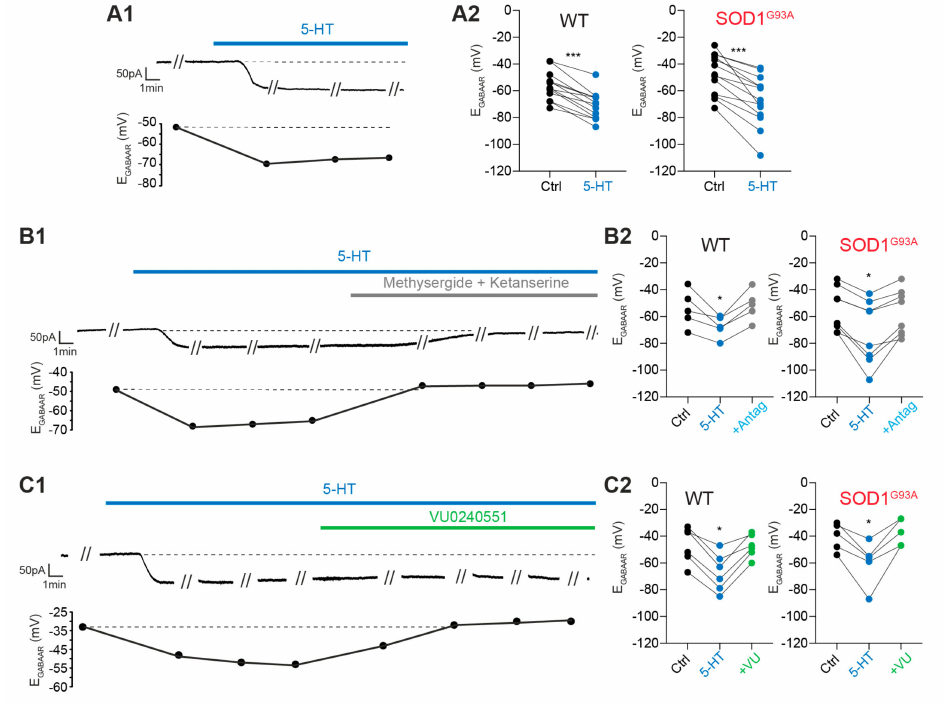
Figure 3. Modulation of the E GABAAR by exogenous 5-HT application. ( A1 ) 5-HT-induced inward current and E GABAAR decrease in a representative E17.5 MN. ( A2 ) E GABAAR values measured in the same WT MNs (left panel) and SOD1 G93A MNs (right panel) under control conditions (black circles) and in the presence of 5-HT (blue circles). ( B1 ) Involvement of the 5-HT 2 receptor in the 5-HT-mediated modulation of the E GABAAR in a representative E17.5 MN. ( B2 ) Quantitative analysis of the E GABAAR in the same WT MNs (left panel) and SOD1 G93A MNs (right panel) under control conditions (black circles), in the presence of 5-HT (blue circles) and in the presence of 5-HT + methysergide and ketanserine (grey circles). ( C1 ) 5-HT hyperpolarized the E GABAAR by acting on KCC2, as depicted in a representative E17.5 MN. ( C2 ) Quantitative analysis of the E GABAAR in the same WT MNs (left panel) and SOD1 G93A MNs (right panel) under control conditions (black circles), in the presence of 5-HT (blue circles) and in the presence of 5-HT + VU0240551 (green circles). Drugs were applied at 10 µ M. * p < 0.05; *** p < 0.001, Wilcoxon matched-pairs signed rank test. Experiments in B–C are from the set of experiments used in